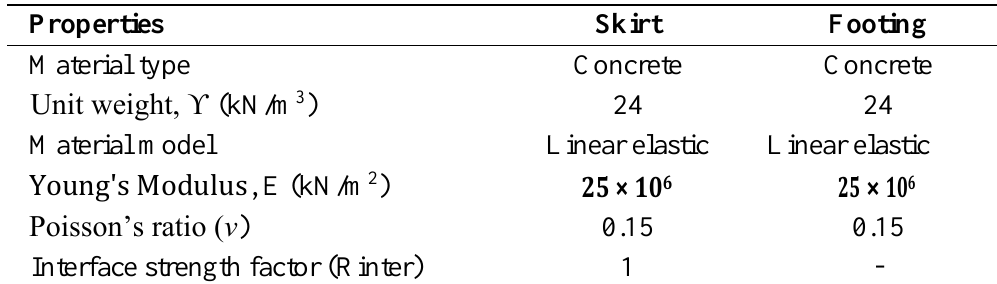
Table 1. Parameters of structure